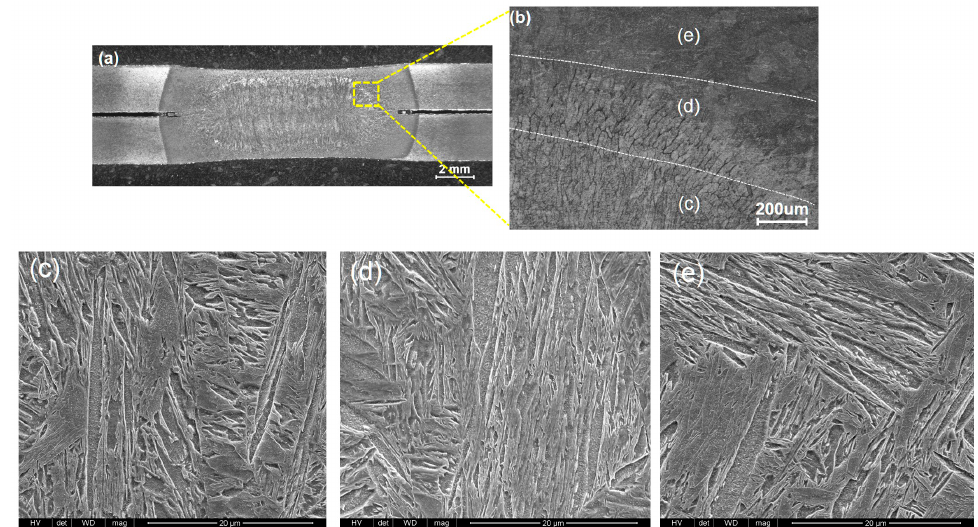
Figure 14. Cross-section characteristic of the spot welds: ( a ) overall view; ( b ) enlarged view of zone ( b ) in ( a ); ( c ) enlarged view of nugget zone in ( b ); ( d ) enlarged view of transition zone between nugget and upper-critical HAZ; ( e ) enlarged view of upper-critical HAZ.